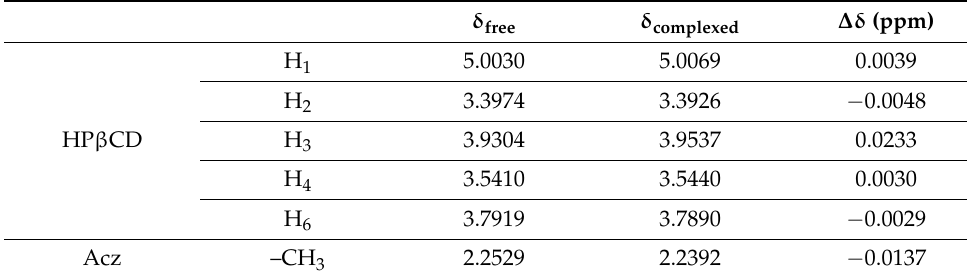
Table 3. Chemical shifts (ppm) in Acz and HPbCD in the free and complexed forms